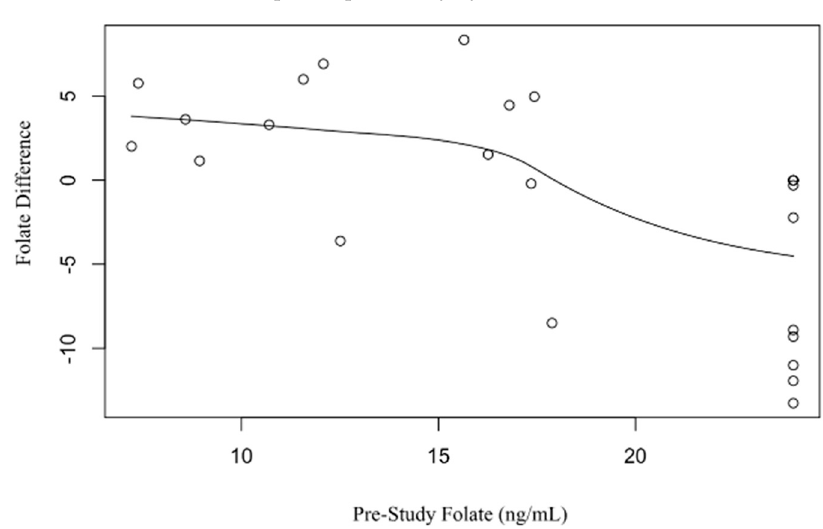
Figure 4. Baseline folate level (ng/mL) predicting pre- to post-study folate difference.